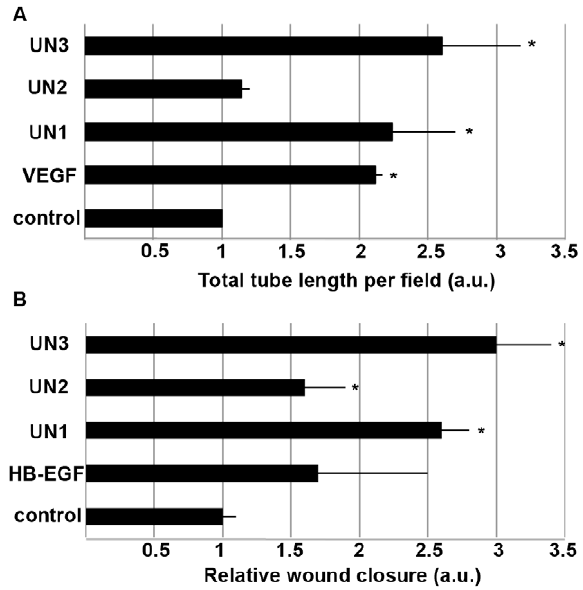
Figure 4. Platelet rich plasma derived peptides stimulate in vitro angiogenesis and epithelial responses to injury. A – In vitro angiogenesis assay. Human capillary endothelial cells were plated on growth factor reduced Matrigel as described in Materials and Methods. The media was supplemented with either DMEM supplemented with 1% BCS or 250 nM of UN1, UN2 or UN3 peptides. Cells that have received DMEM/1% in the presence of 10 ng/ml VEGF served as positive control. Total tube length was measured at 4 h post-plating. Relative tube length compared to control is shown. B – In vitro epithelial wound healing assay. NHEK cells were plated and injured as described in Material ad methods. The following experimental conditions were used: basal keratinocyte growth media (control), 10 ng/ml HB-EGF (positive control), 0.5 nM UN1, UN2 or UN3 peptides. Relative wound closure is shown. Data are presented as mean + / 2 standard error; * - indicates p , 0.05.